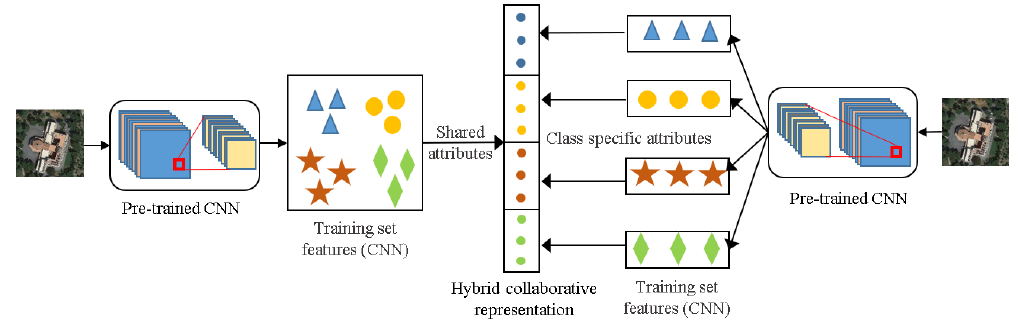
Figure 1. Scheme of our proposed hybrid collaborative representation algorithm. The left part is the collaborative representation to extract the shared attributes while the right part is the class-specific collaborative representation to extract class-specific attributes. Their combination forms our hybrid collaborative representation